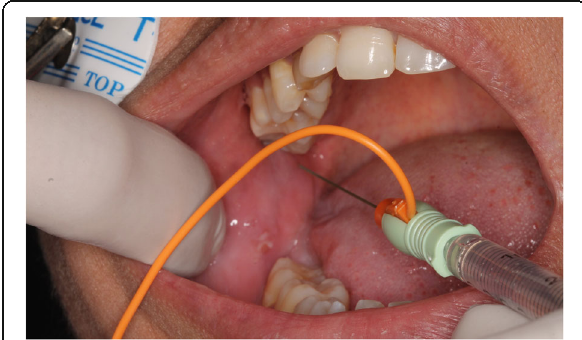
Fig. 1 Photograph showing the electromyograph-guided injection of botulinum toxin solution into the lateral pterygoid muscle via an intraoral approach